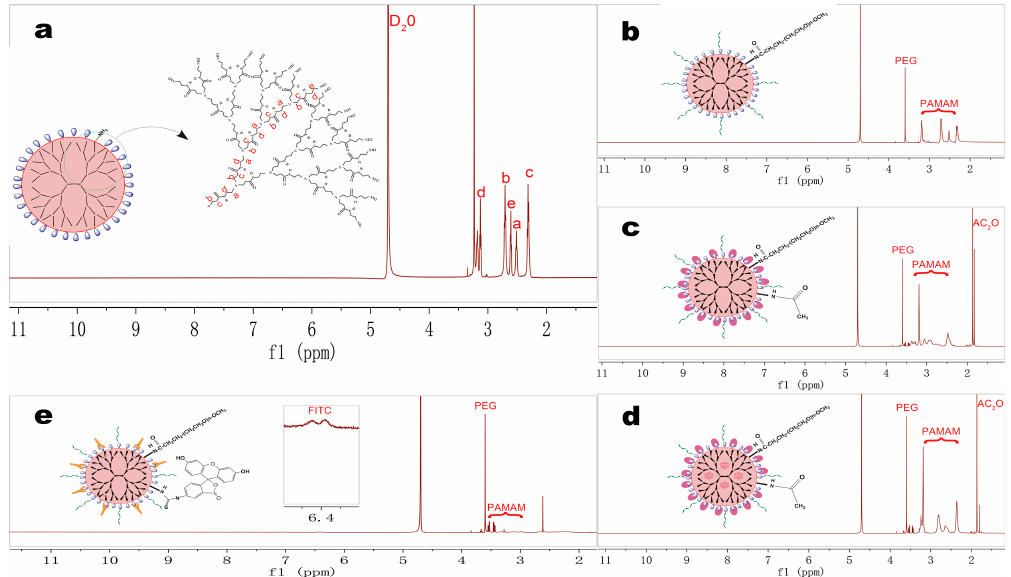
Figure 2. 1 H-NMR spectra of PAMAM dendrimer nanocomposites were obtained at 1 mg/mL concentration in D 2 O on a 600 MHz NMR spectrometer. ( a ) PAMAM G5.NH 2 ; ( b ) mPEG-PAMAM